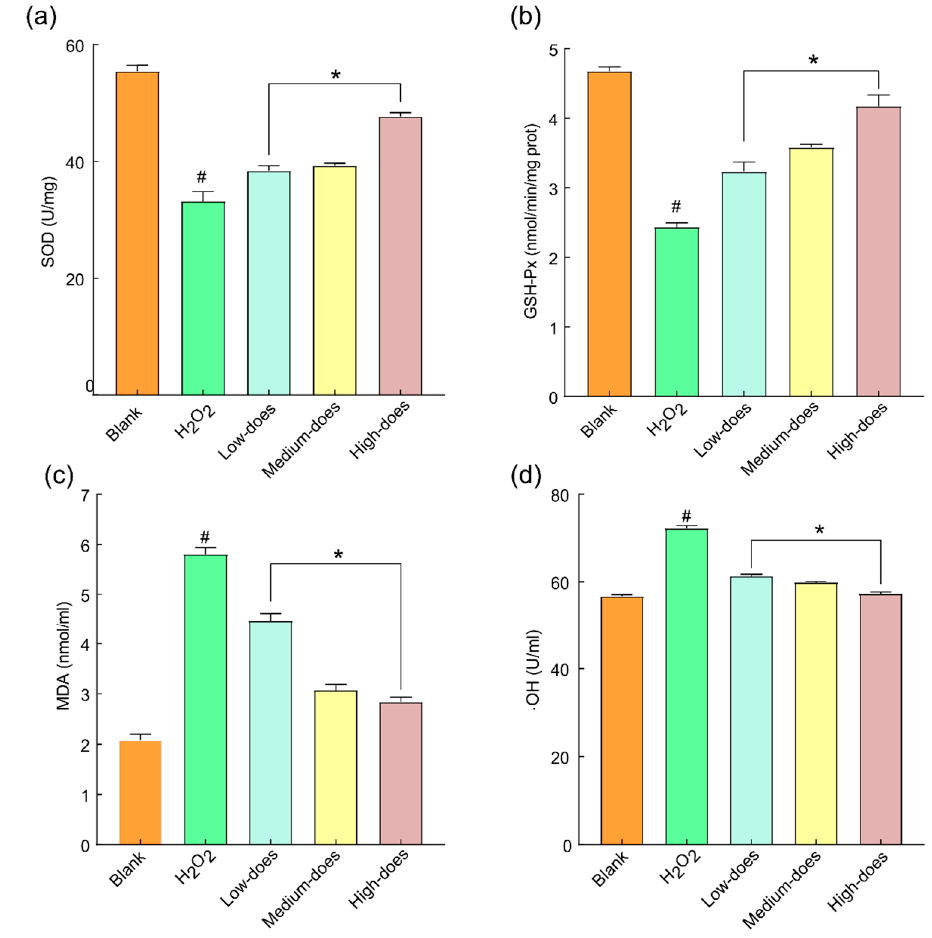
Figure 5. Effects of BMFs on SOD, GSH-Px, MDA, and ·OH in H 2 O 2 -damaged rabbit lens epithelial